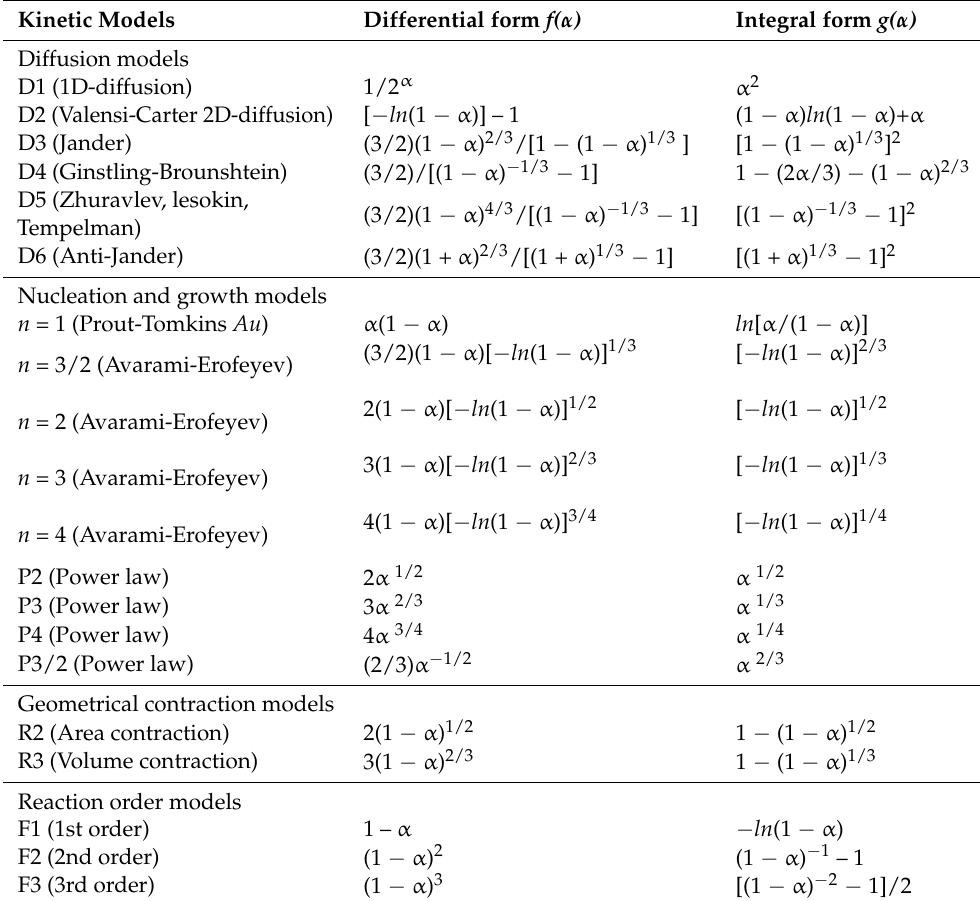
Table 1. Expressions of the differential form f( α ) and integral form g( α ) of most well-known solid-state kinetic